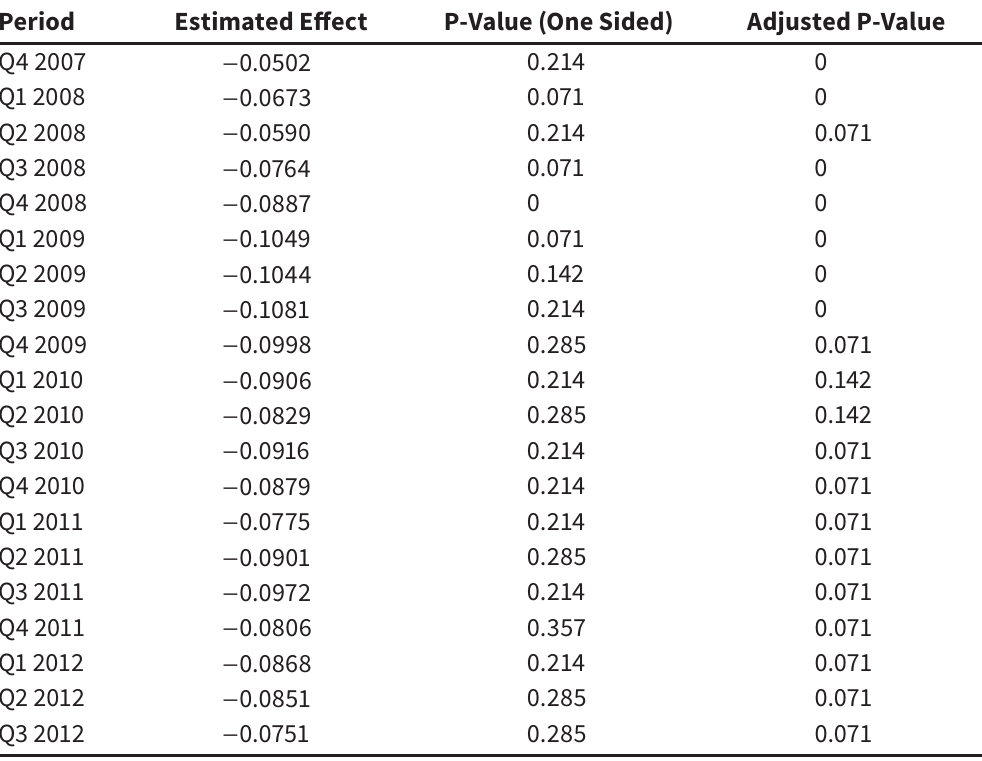
Treatment Effects and Significance for Log Employment in Puerto Rican Accom- modation and Food Industry (Puerto Rican Industry Donors)